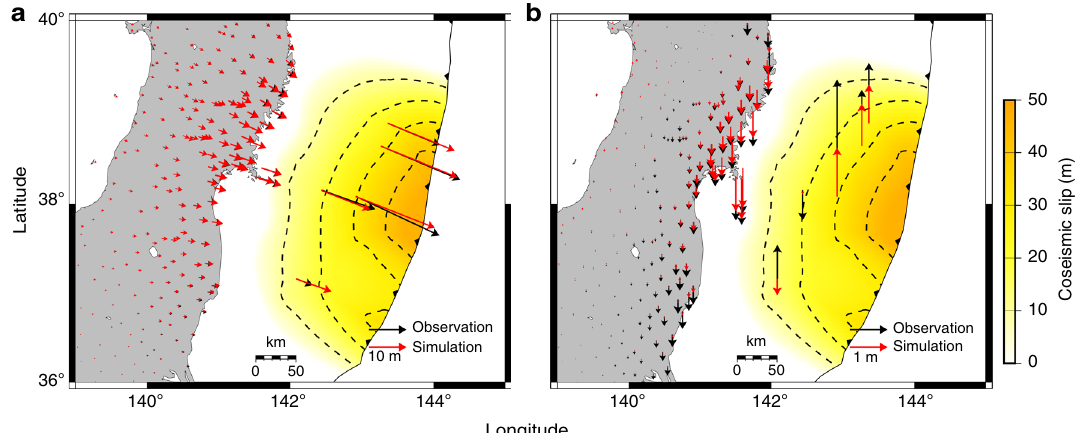
Fig. 9 The input coseismic slip and comparison between computed and observed coseismic displacement including both the land and sea fl oor stations. a Horizontal displacement. b